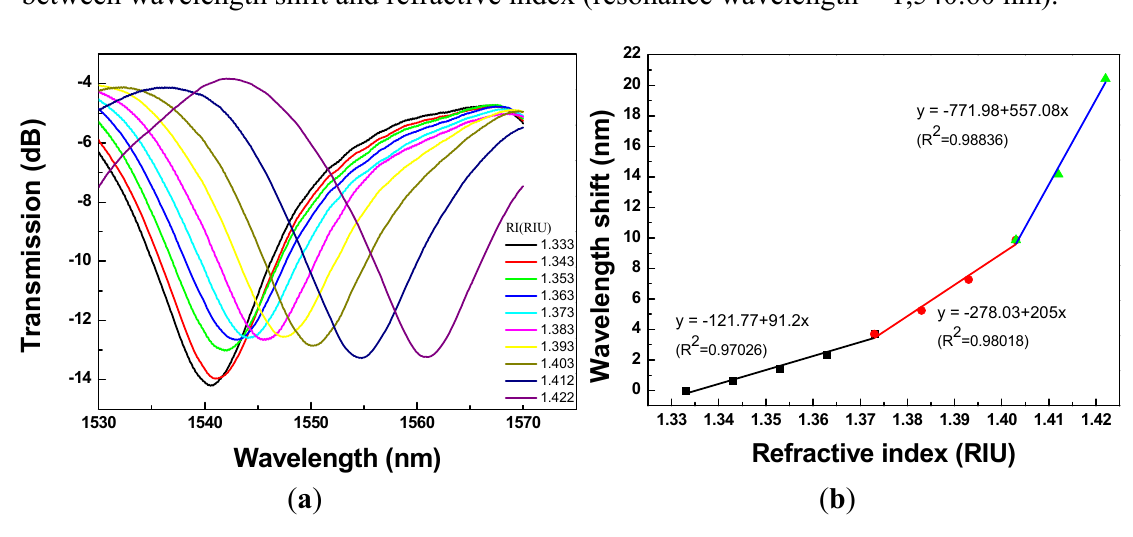
Figure 8. A 1.34-cm PCF interferometer with: ( a ) the transmission spectra for sensing different refractive indices of the sucrose solution (RI = 1.333 − 1.422); ( b ) the relationship between wavelength shift and refractive index (resonance wavelength = 1,540.60 nm).